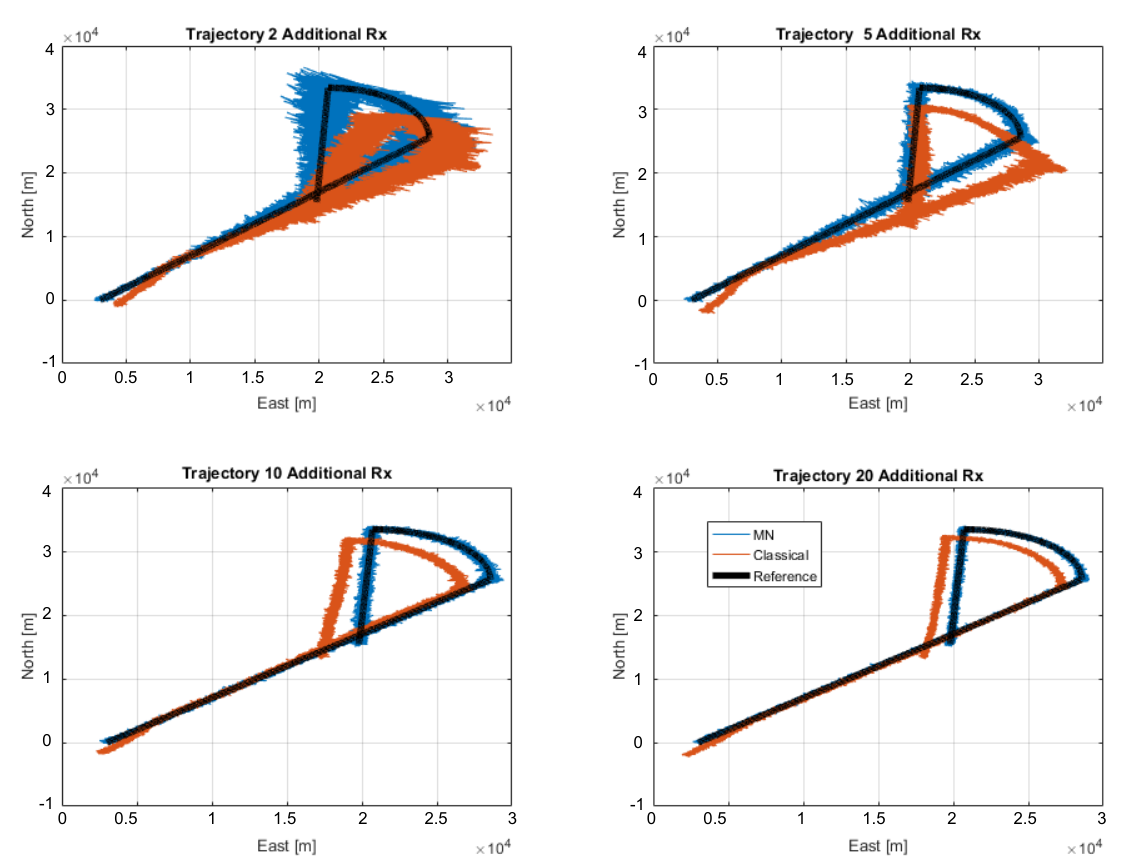
Figure 13. Comparison between the actual trajectory (black) and that estimated with the traditional (red) and with the MN (blue) algorithms. Four configurations of the receivers network are considered by adding to the the baseline Rx, respectively: 2 (top-left), 5 (top-right), 10 (bottom-left) and 20 (bottom-right) additional